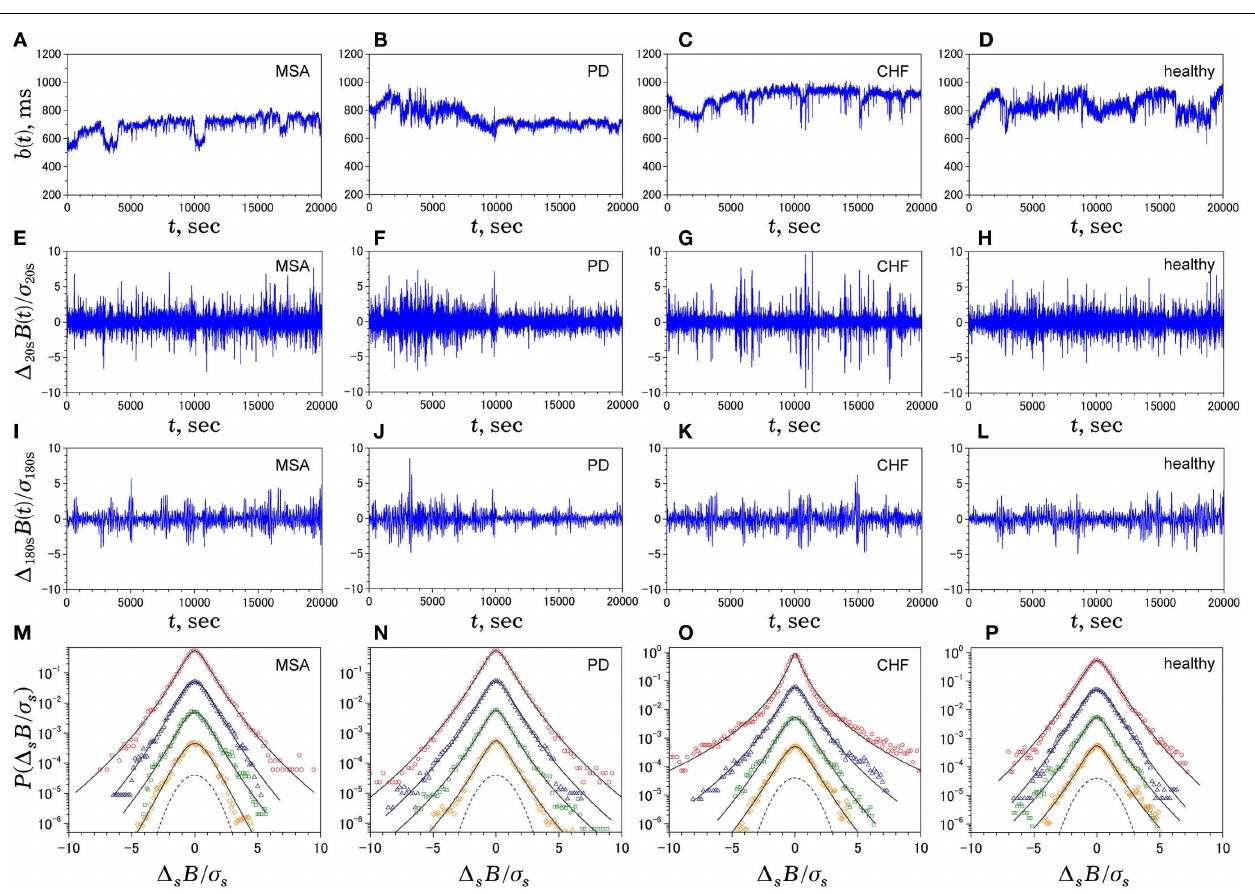
on the right-of-center side (C,G,K,O) are data for a 83-year-old female patient FIGURE 2 | Multiscale PDF characterization of heart rate variability. with congestive heart failure (CHF) who died 54days after the measurement. Illustrative examples of time series of NN intervals b ( t ) (A–D) , time series of Δ Δ The panels on the rightmost side (D,H,L,P) are data for a control subject 180sB ( i ) (I–L) , and standardized PDFs (in 20sB ( i ) (E–H) , time series of (84-year-old male). For comparison, the dashed line denotes a Gaussian logarithmic scale) of Δ s B ( i ) for (from the top to bottom) s = 20, 60, 180, 300s distribution. Note that, while the raw b ( t ) for the patients looks much different (M–P) , where σ s denotes the SD of Δ s B ( i ). In solid lines, we superimpose the from that for the control subject, the degrees of non-Gaussianity (i.e., the PDF approximated by Castaing’s model (Castaing et al., 1990).The panels on shapes of PDF) remain unaltered across scales for MSA and PD patients and the leftmost side (A,E,I,M) are data for a 60-year-old male patient with the healthy control, except for those for the CHF patient at shorter scales multiple system atrophy (MSA).The panels on the left-of-center side (B,F,J,N) (G,O) are data for a 68-year-old male patient with Parkinson disease (PD).The panels